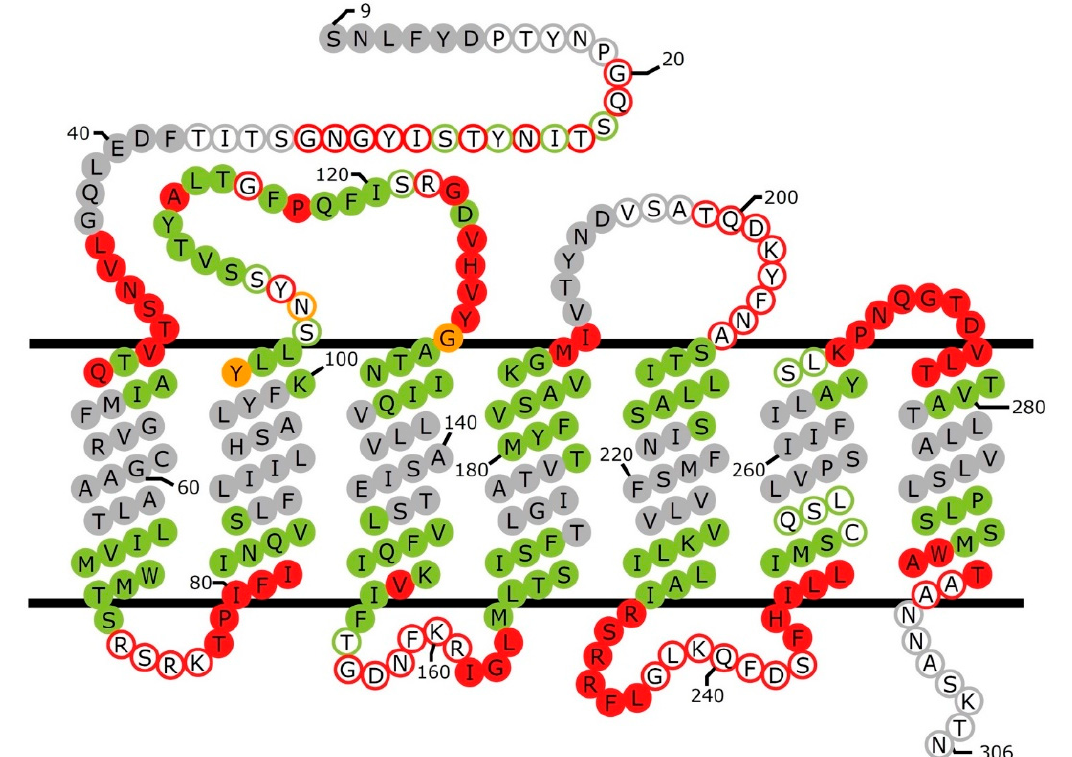
Figure 1. Schematic view of accessibility measurements and helical segments in Ste2p. Filled circles of different colors indicate positions of residues that map to α -helical regions of the ligand-free structure (PDB: 7QB9) [37]. Circles of different colors with white backgrounds show the positions of residues that do not reside in α -helical segments. Positions that, when replaced by cysteine, exhibited greater than 50% reactivity with MTSEA-biotin, compared to controls presented in the corresponding publications [43–46,48], are shown in red. Positions where cysteine substitutions were tested but exhibited less than 50% reactivity with MTSEA-biotin are shown in green. Positions that were not tested for cysteine accessibility are shown in grey. Positions labeled in orange were reported to have different accessibilities in different publications. Approximate boundaries of the membrane region are indicated. Positions of amino acids in the figure are not intended to correspond to their actual locations in the cryo-EM structure. The first eight residues of the N terminus and the last ~125 residues at the C terminus of Ste2p were not resolved in the structure, and are not included in the figure.